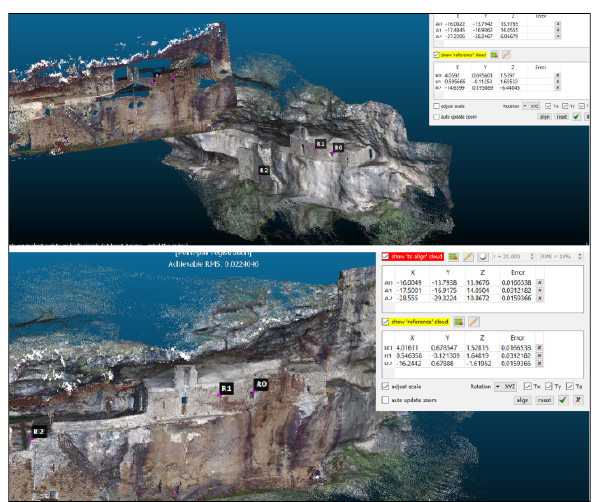
Figure 18. (A) Alignment phases with numerical control